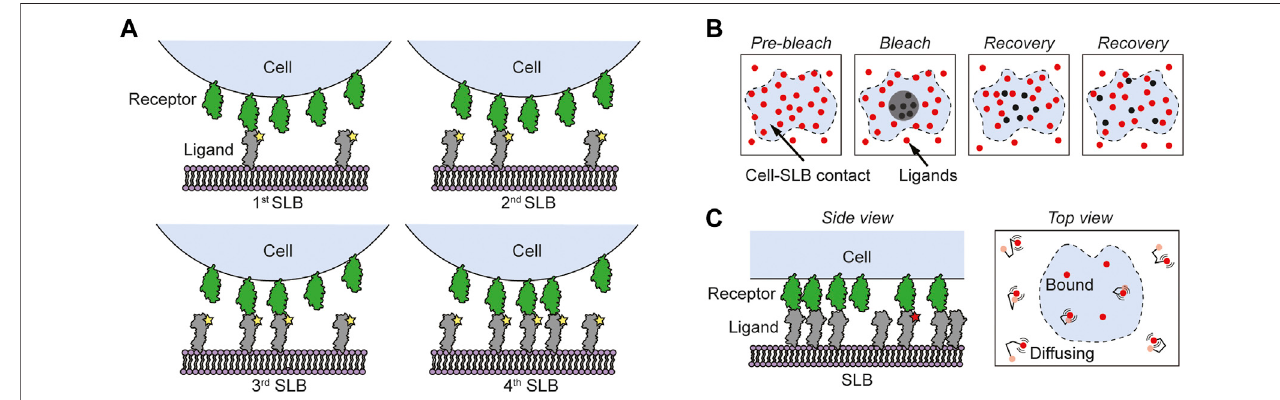
FIGURE 3 | Different fl uorescence-based methods for measuring 2D binding kinetics in cell-SLB contacts. (A) In the Zhu-Golan method cells expressing the studiedreceptorinteractwithSLBscarryingthecorrespondingligand.Bymeasuringtheaccumulationof fl uorescentlylabeledligandsincell-SLBcontactsforSLBswith different densities of ligands, the 2D K d of the interaction can be obtained using Eq. 4 . (B) Using FRAP adelimited area of the ligands (red circles) in the cell-SLB contact (blue area) is photobleached and by following the rate of recovery the lifetime of the interaction can be estimated. (C) Single-molecule fl uorescence microscopy is used to track the motion of fl uorescently labeled ligands (red circles) in the cell-SLB contact (blue area). Unlabeled ligands are here included to facilitate the formation of the cell-SLB contact. When the ligands bind, they stop moving, and from this the average 2D lifetime of the interaction can be